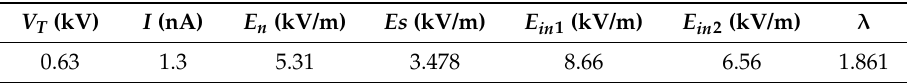
Table 3. Demarcation experiment of λ in an ion flow